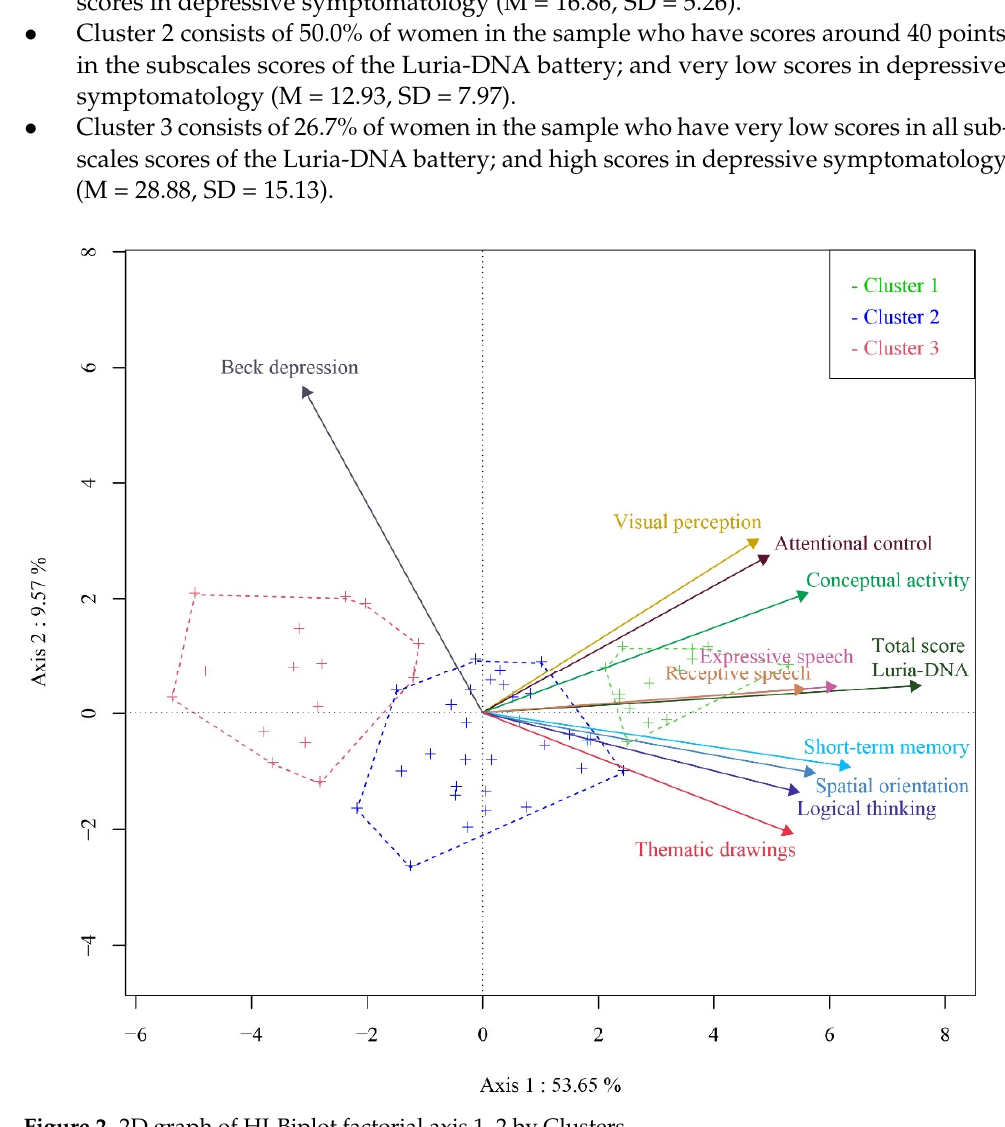
Figure 2. 2D graph of HJ-Biplot factorial axis 1–2 by